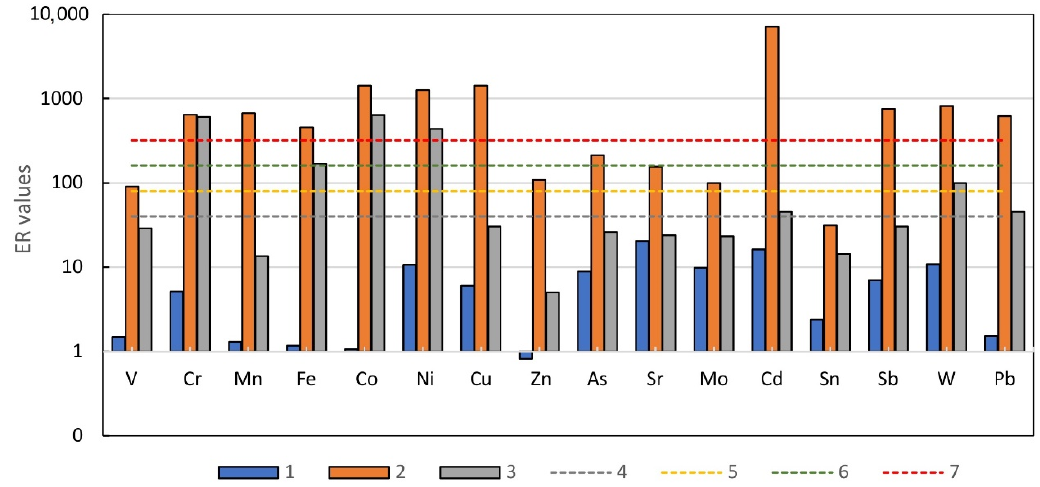
Figure 6. Potential ecological risk index values: 1—dissolved forms; 2—particulate forms; 3—total; 4–7—ecological risk levels: 4—low (<40); 5—moderate (40–80); 6—considerable (80–160); 7—high (320). The values above 320 characterize an extreme ecological